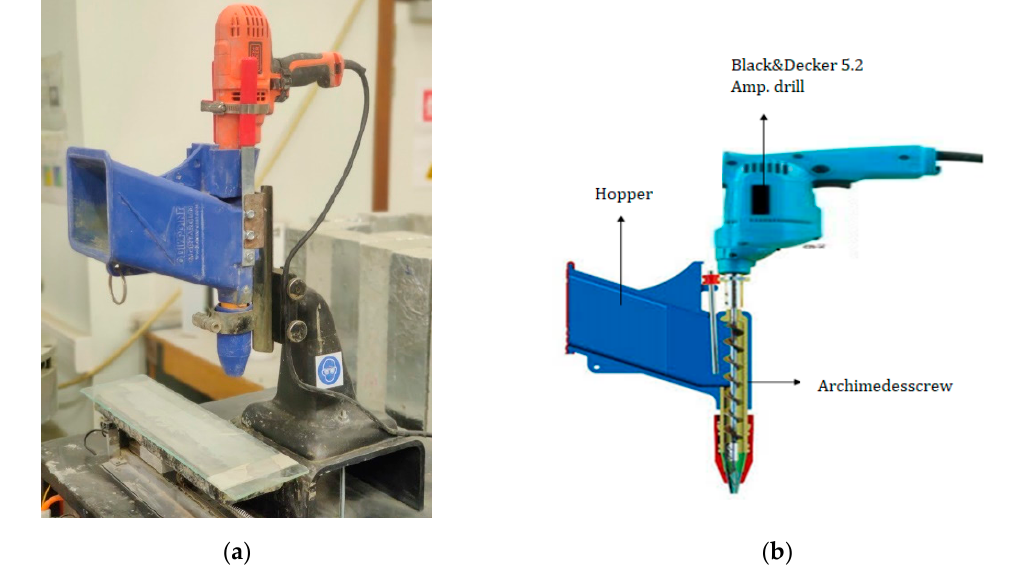
Figure 2. ( a ) Print device used in the current study, ( b ) equipped with a Quickpoint mortar gun with